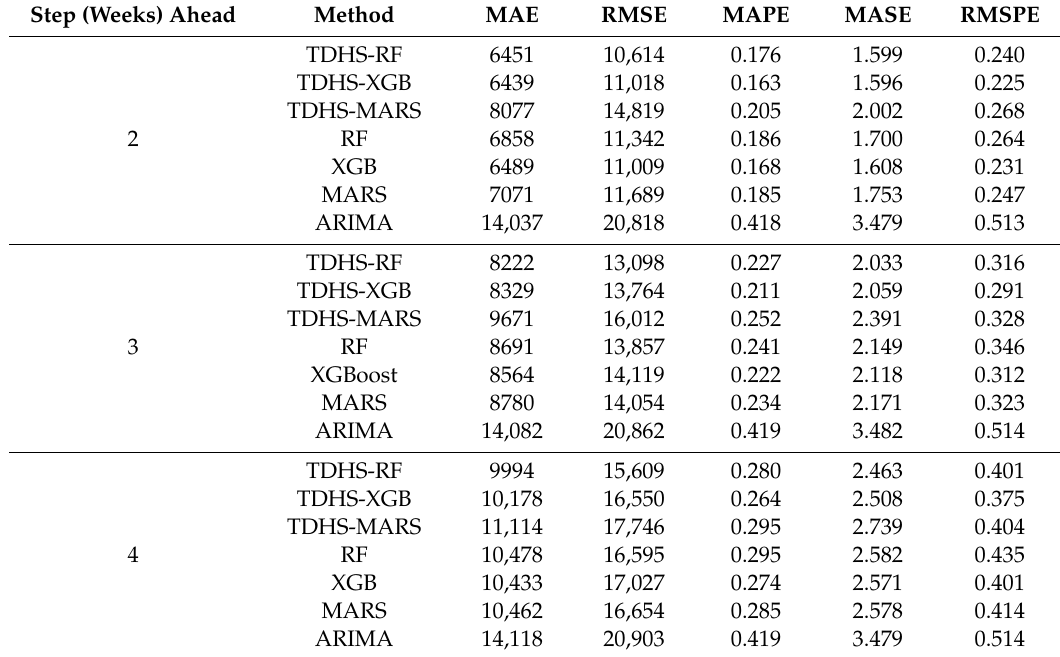
Table 3. Forecasting results of two to four steps (weeks) ahead of outpatient visits.